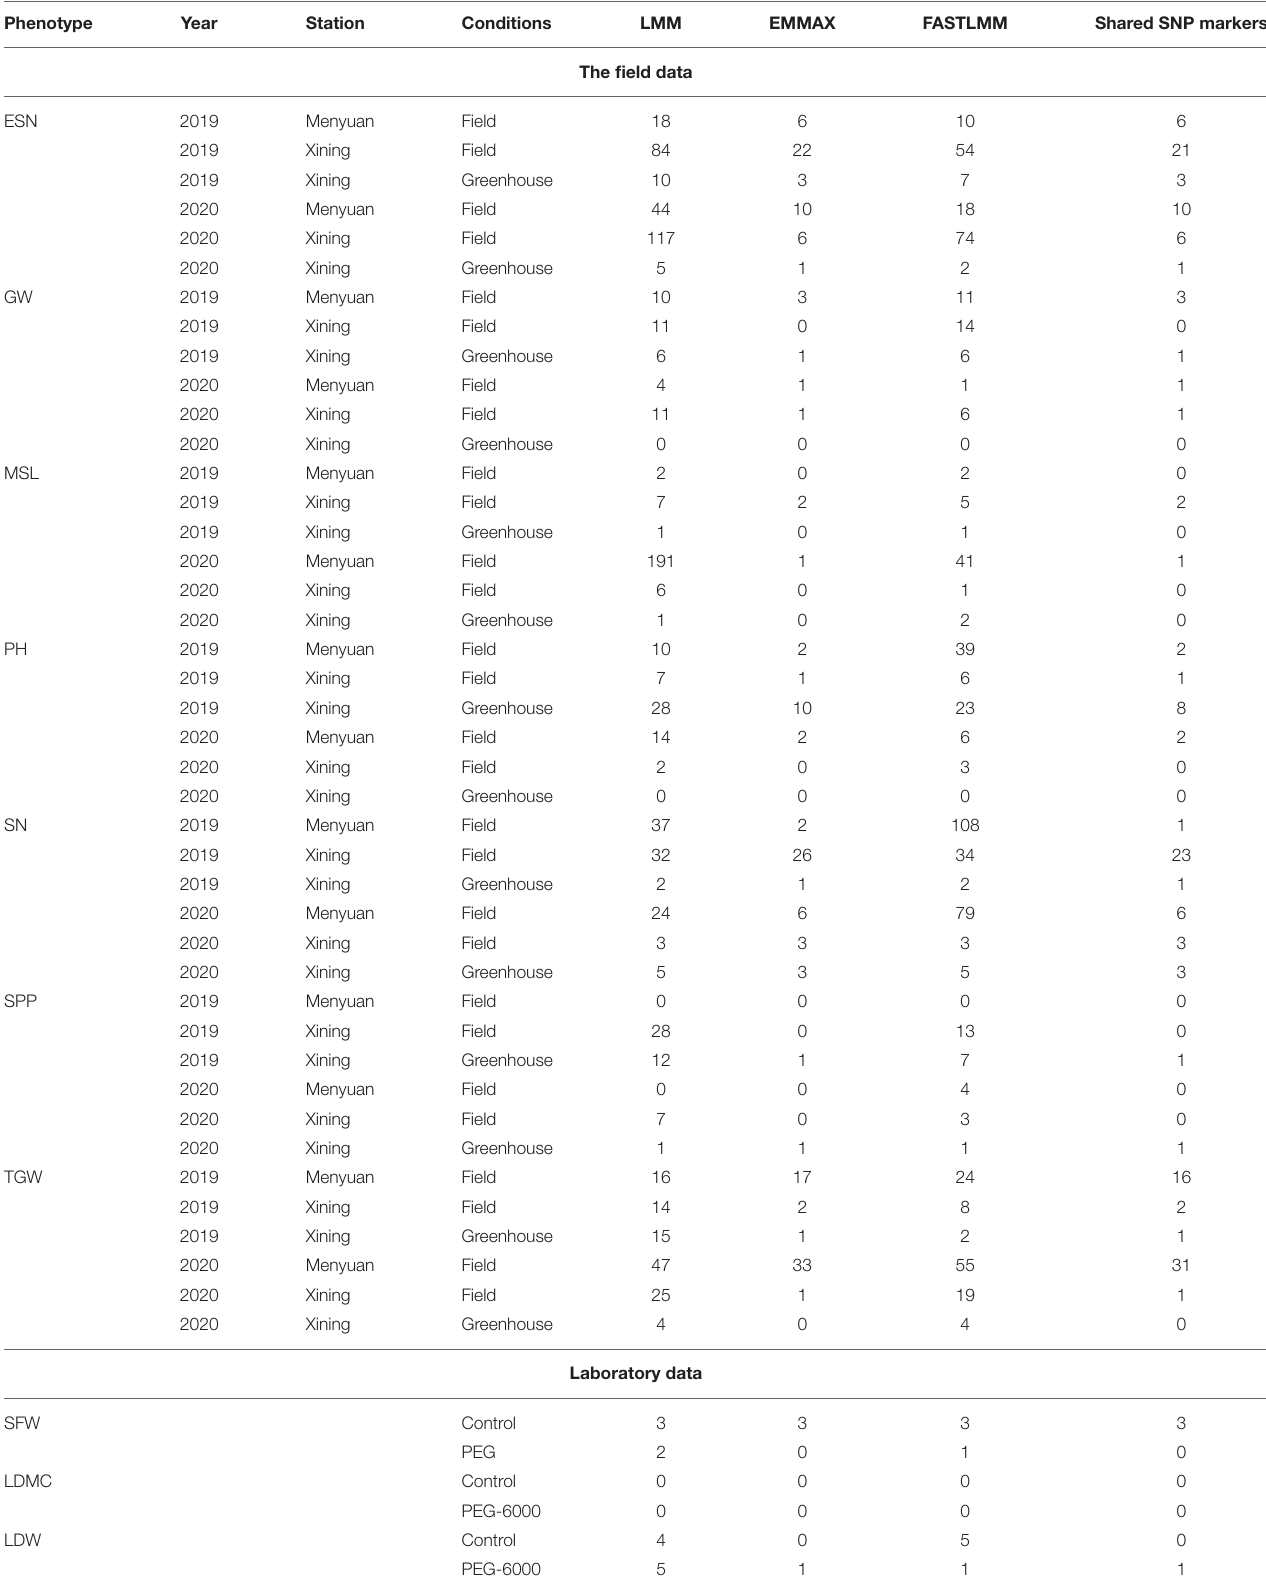
TABLE 2 | SNP markers for each phenotype based on different GWAS analysis models.